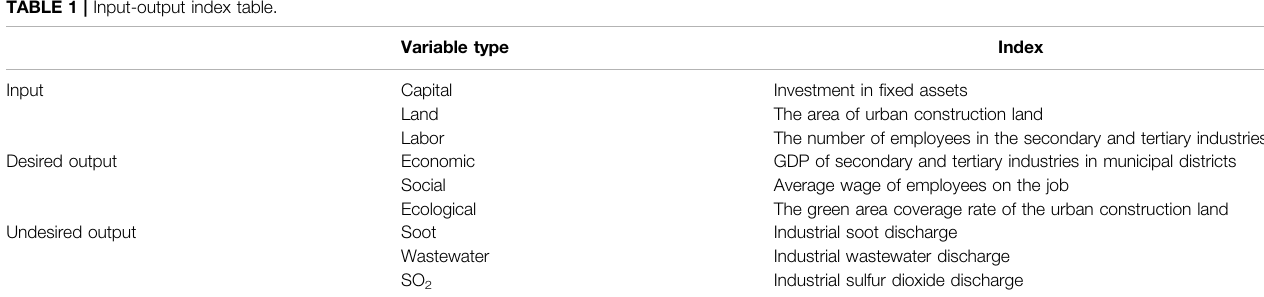
TABLE 1 | Input-output index